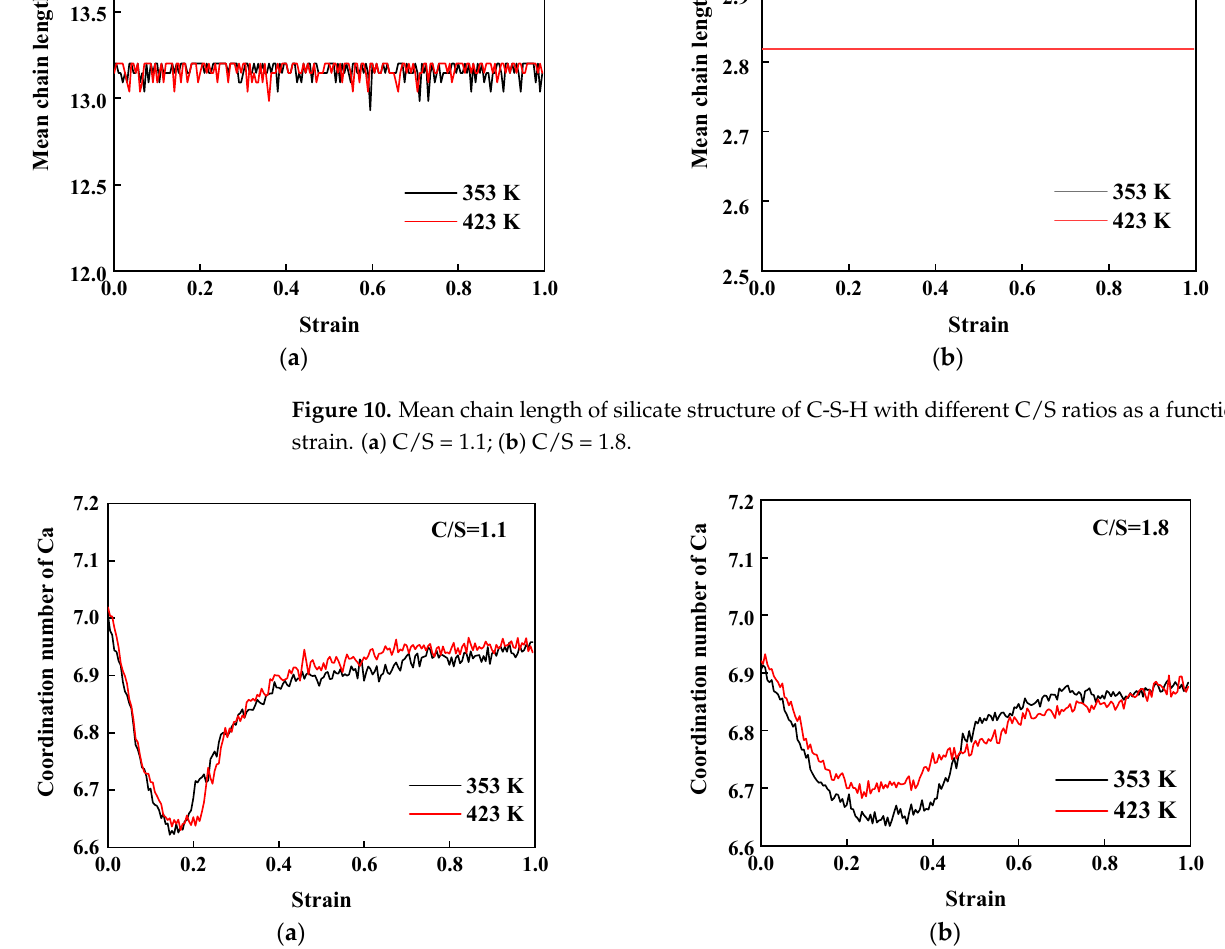
Figure 11. Coordination number of Ca of C-S-H with different C/S ratios as a function of strain. ( a ) C/S = 1.1; ( b ) C/S = 1.8.